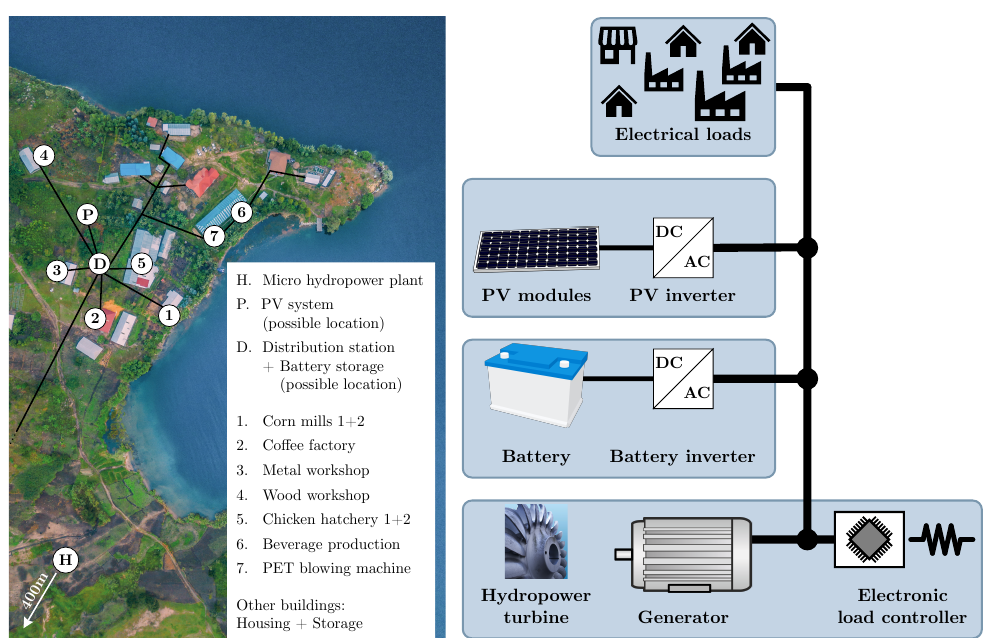
Figure 4. Aerial image of the industrial campus with locations of generators and consumers ( left ), sketch of the assumed system topology ( right ).